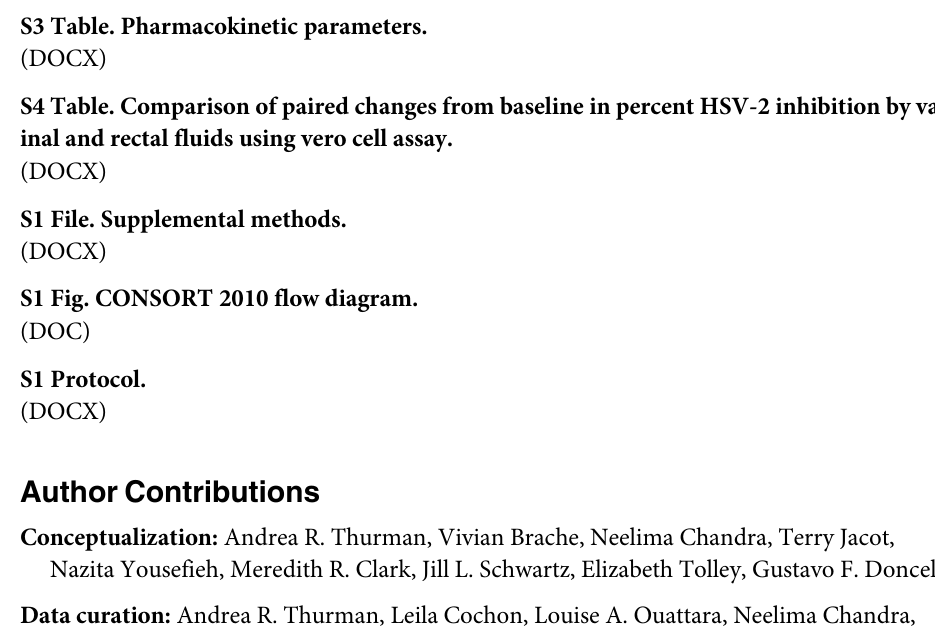
S2 Table. CD4 and CCR5 positive cell density in cryopreserved samples. S3 Table. Pharmacokinetic parameters. S4 Table. Comparison of paired changes from baseline in percent HSV-2 inhibition by vag- inal and rectal fluids using vero cell assay.